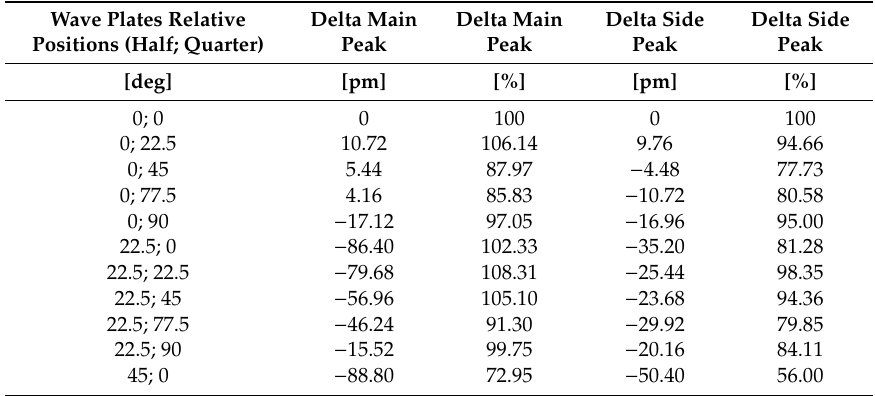
Table A1. Recorded values for the polarization experiment. The wave plates’ relative positions are relative to the linear polarizer in front of